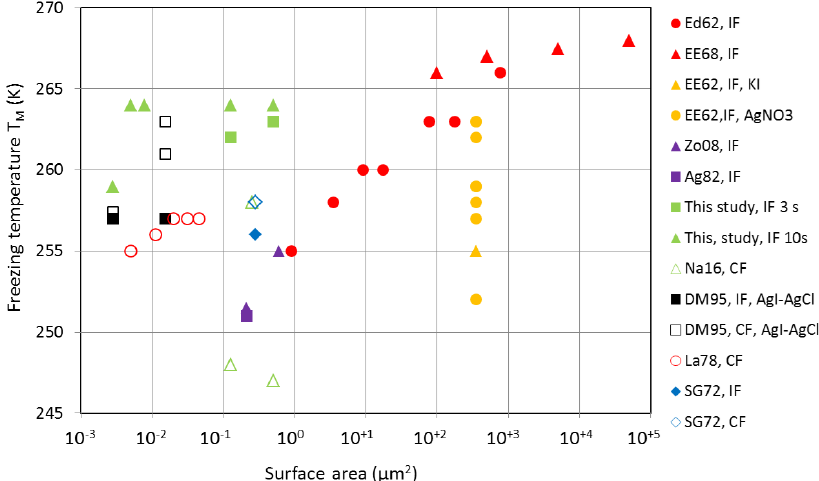
Figure 2. Median freezing temperatures T M as a function of particle surface area per droplet for immersion freezing (IF, filled symbols) and contact freezing (CF, open symbols). Filled red symbols: droplets on hydrophobic glass slips with previously deposited AgI particles prepared by precipitation in stoichiometric ratio (circles: Edwards et al., 1962, Ed62; triangles: Edwards and Evans, 1968, EE68). Filled orange symbols: droplets on hydrophobic glass slips with previously deposited AgI particles prepared by precipitation in nonstoichiometric ratio (Edwards and Evans, 1962, EE62; circles: excess of AgNO 3 ; triangles: excess of KI; note that circles and triangles overlap). Filled purple symbols: emulsion of AgI containing water droplets prepared by in situ precipitation in stoichiometric ratio (triangles: Zobrist et al., 2008, Zo08; square: Aguerd et al., 1982, Ag82). Filled green symbols: freely falling water droplets with immersed AgI particle (squares: this study, 3s residence time; triangles: this study, 10s residence time). Open green triangles: water droplets freely falling through chamber with AgI aerosol (Nagare et al., 2016, Na16). Filled black squares: cloud chamber filled with droplets from CCN activation of AgI–AgCl particles (DeMott, 1995, DM95). Open black squares: water droplets in cloud chamber with AgI–AgCl aerosol (DeMott, 1995). Open red circles: water droplets in cloud chamber filled with AgI aerosol (Langer, 1978, La78). Blue diamonds: freely falling droplets intercepting AgI aerosol; filled diamond: immersion mode; open diamond: contact mode (Sax and Goldsmith, 1972,